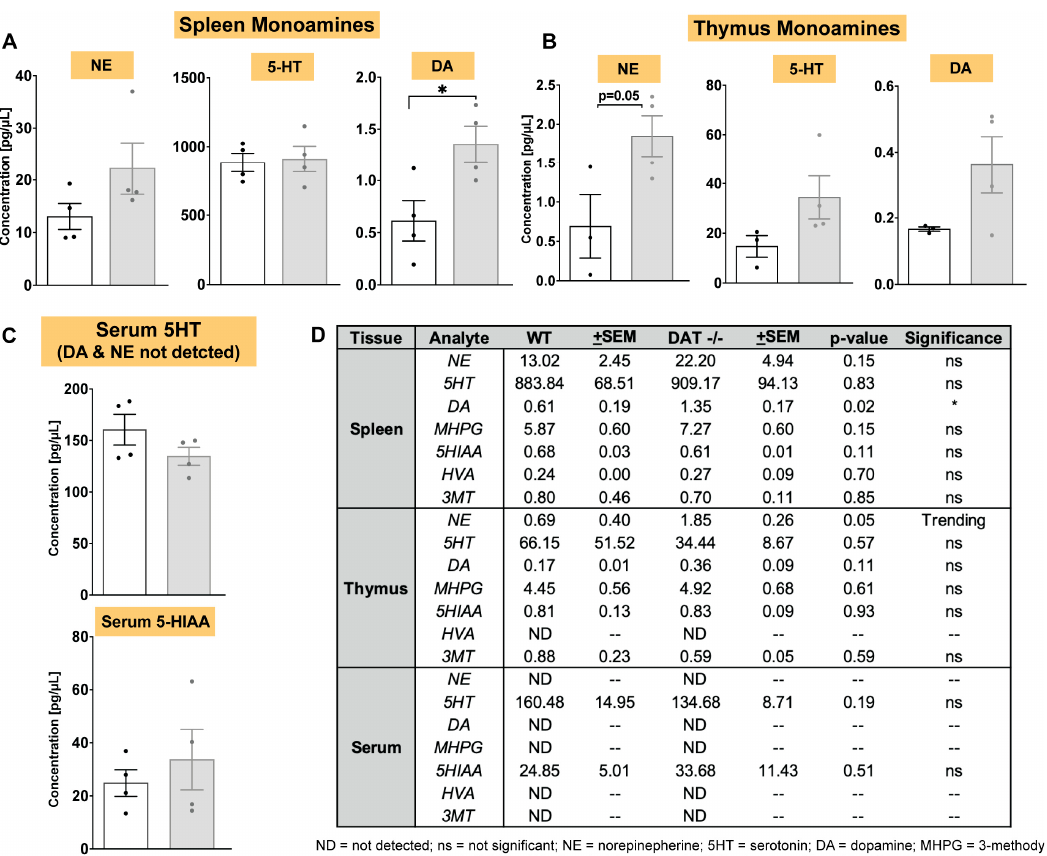
Figure 2. In DAT − / − mice, norepinephrine and dopamine levels are increased in spleen and thymus, but not in circulating serum. Peripheral blood, spleen and thymus were isolated from DAT − / − mice and WT controls. The samples were lysed and assayed via HPLC for monoamines and their metabolites. ( A ) Relative to WT controls, DAT − / − mice exhibit significantly increased splenic dopamine and ( B ) significantly increased thymic norepinephrine, with no change in monoamine metabolites in either spleen or thymus. ( C ) Only serotonin and its metabolite 5-HIAA are detectable in serum of DAT − / − and WT mice; they are not significantly different between the two groups. ( D ) Mean ± SEM values for monoamine levels, their metabolite, p -values, and significance for each are shown. (Unpaired two-tailed t -test, with Holm–Sidak correction for multiple comparisons; n = 3–4/group; * p <